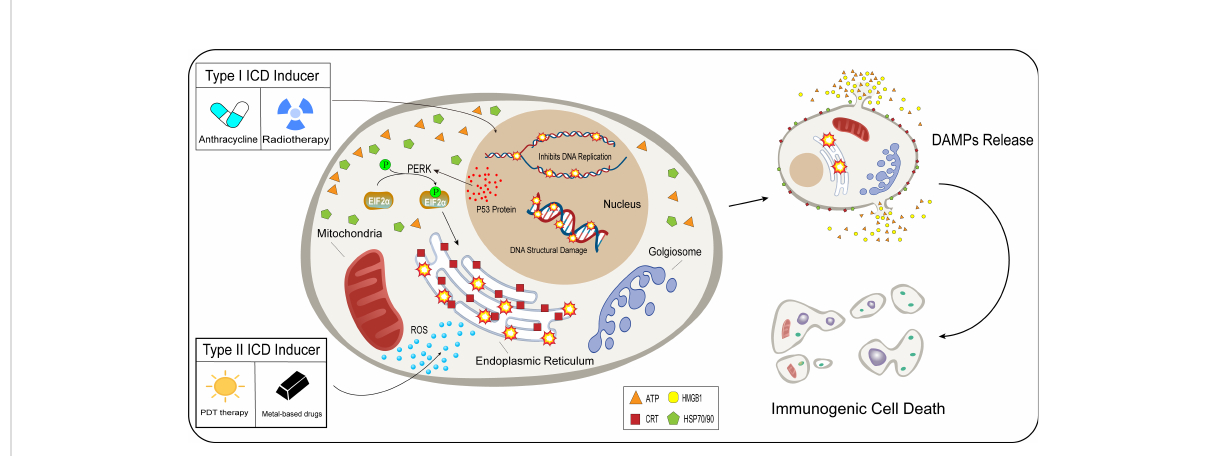
FIGURE 2 Difference between type I and type II inducers. After acting on tumor cells, type I inducers (anthracyclines, radiotherapy), affect the normal functions of tumor cells, including hindering DNA replication and promoting the breaking of the DNA structure in the nucleus. Type I inducers can increase the expression of P53 protein and enhance protein stability. p53 protein is involved in the activation process of PERK signaling in tumor cells, EIF2 a undergoes phosphorylation, and the endoplasmic reticulum undergoes a stress response under the in fl uence of a series of actions. Unlike type I inducers, type II inducers (PDT therapy, metal-based drugs), generate ROS in large quantities in the cytoplasm and selectively act on the endoplasmic reticulum, which undergoes an oxidative stress response. Type I and type II inducers lead to stress responses in the endoplasmic reticulum through indirect and direct pathways, which trigger the release of DAMPs and induce immunogenic cell